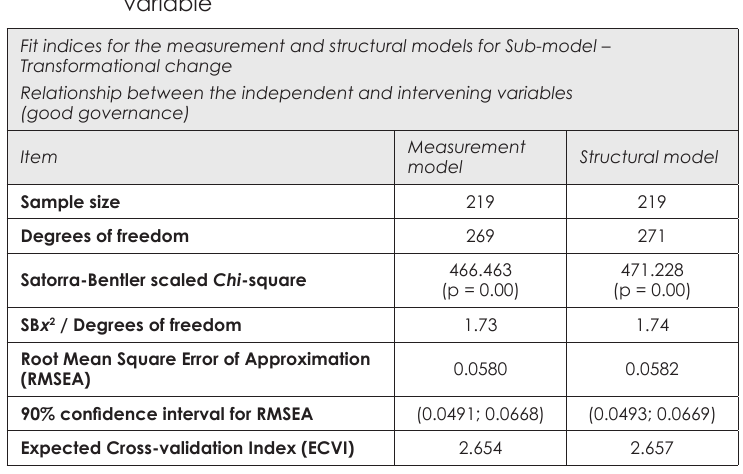
Fit indices for the measurement and structural models for Sub-model – Transformational change – intervening